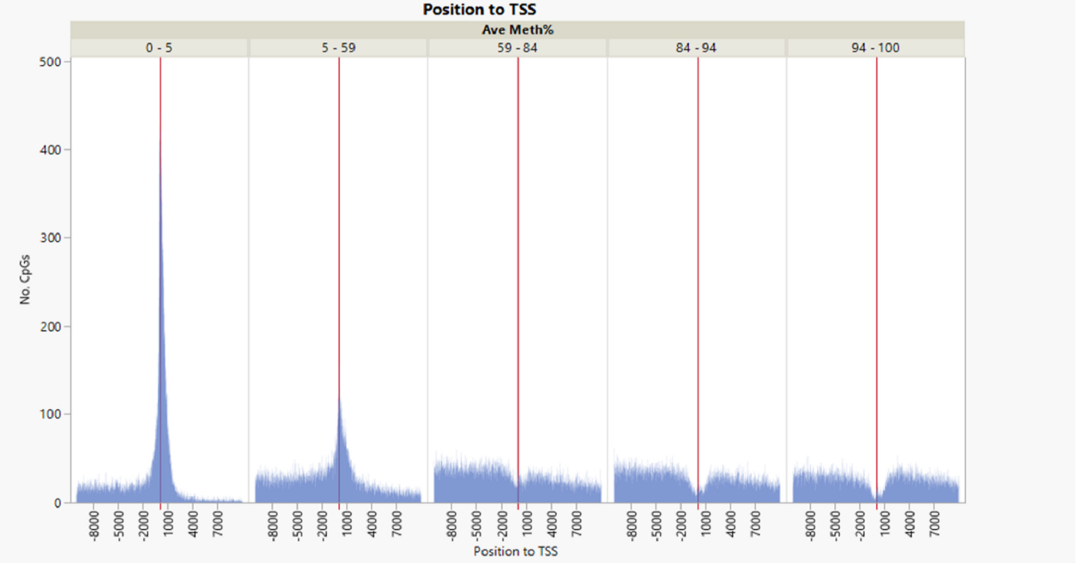
Figure 2. Number of CpGs per nucleotide relative to TSS at different intervals of average methylation percentages.